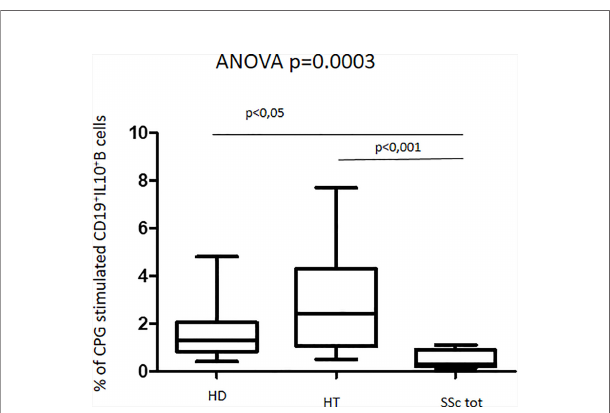
FIGURE 2 | (A) Percentage of Th17 cells in patients with SSc as compared with both HT patients and healthy donors (HD). (B) Percentage of unstimulated CD24hiCD38hi Breg cells in patients with SSc as compared with both HT patients and healthy donors (HD). Kruskal – Wallis followed by Dunn posttest was used for multiple comparisons.